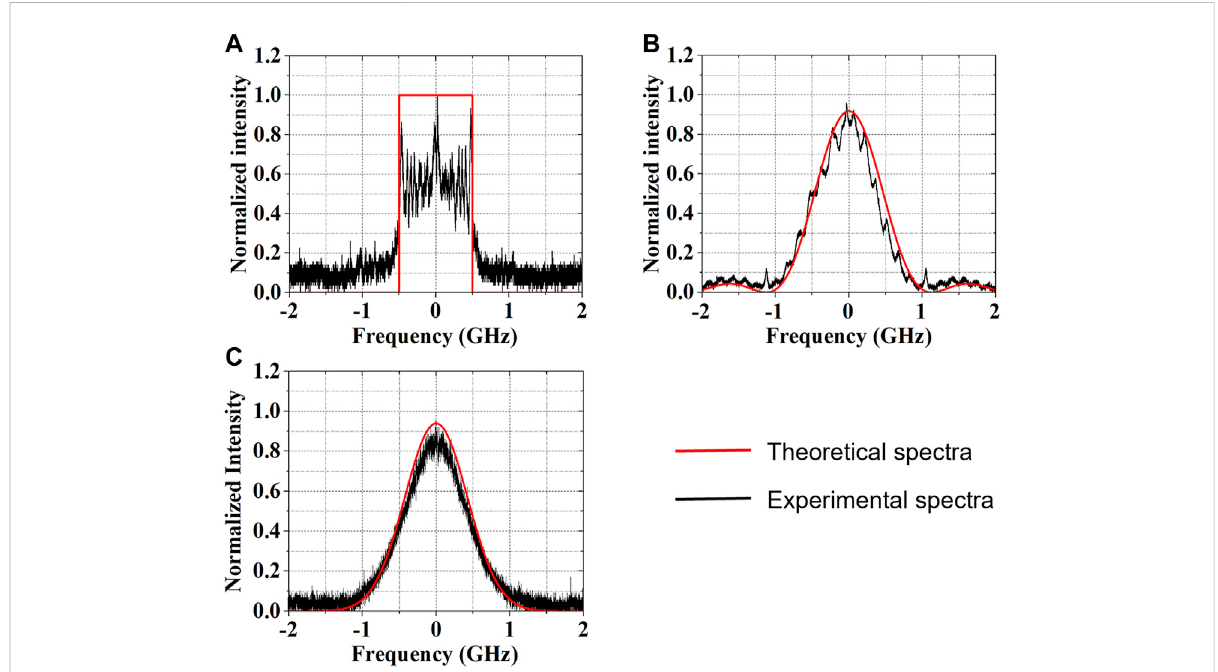
FIGURE 6 The experimental spectra of different modulating techniques (A) PPS with rectangular spectrum, (B) PRBS with sinc 2 spectrum, (C) WNS with Gaussian spectrum.